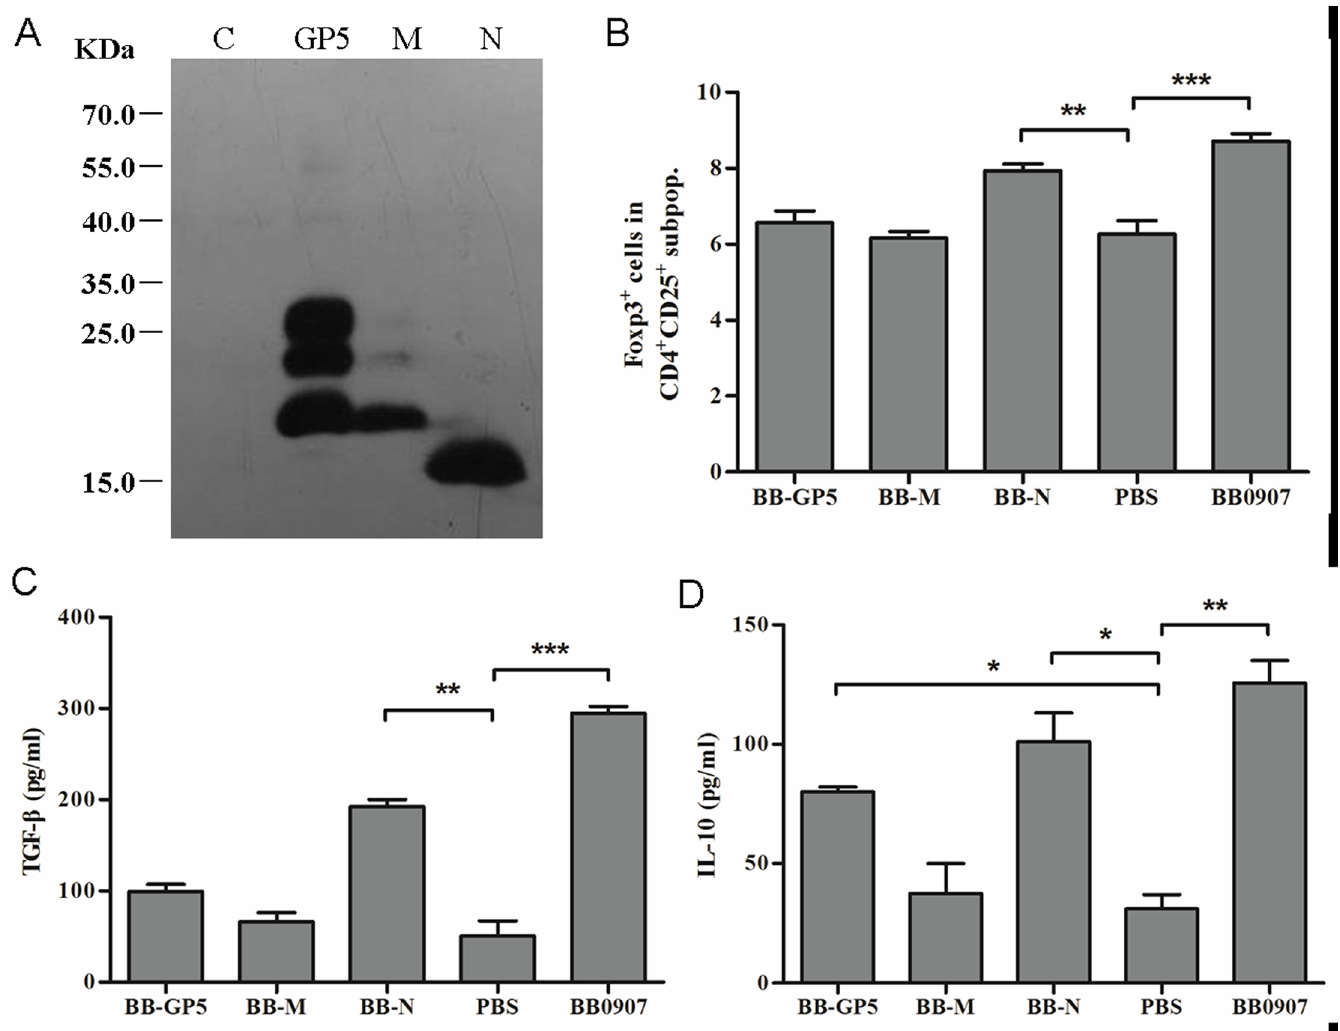
Fig 3. Role of baculovirus-expressed proteins GP5, M and N of HP-PRRSV in induction of Tregs proliferation. (A) Purified recombinant GP5, M and N protein expressed in baculovirus. (B) Percentage of Foxp3 + cells in the gated CD4 + CD25 + subpopulations of GP5, M and N. (C) Concentrations of TGF- β in supernatants of 3-day co-cultures. (D) Concentrations of IL-10 in supernatants of 3-day co-cultures. Data came from three independent experiments. Data analysis was done using one-way ANOVA and significant differences are shown ( * P < 0.05, ** P < 0.01 and *** P <